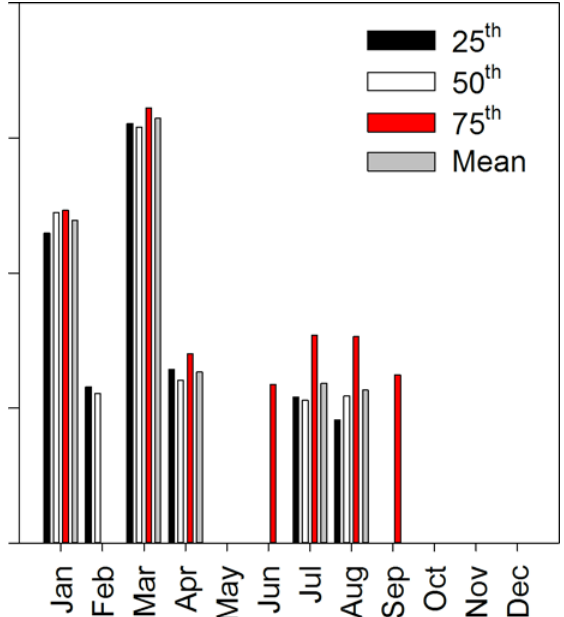
Fig 4. Trends of the descriptive statistics for monthly minimum (A, C) and maximum (B, D) temperature distributions using the modeled SNOTEL + COOP data, 1948 – 2012. Top panels (A, B) show slopes for statistics that describe distribution shifts and bottom panels (C,D) show slopes for statistics that describe distribution shape changes. Only slopes that were significantly different from zero are plotted; missing values indicate